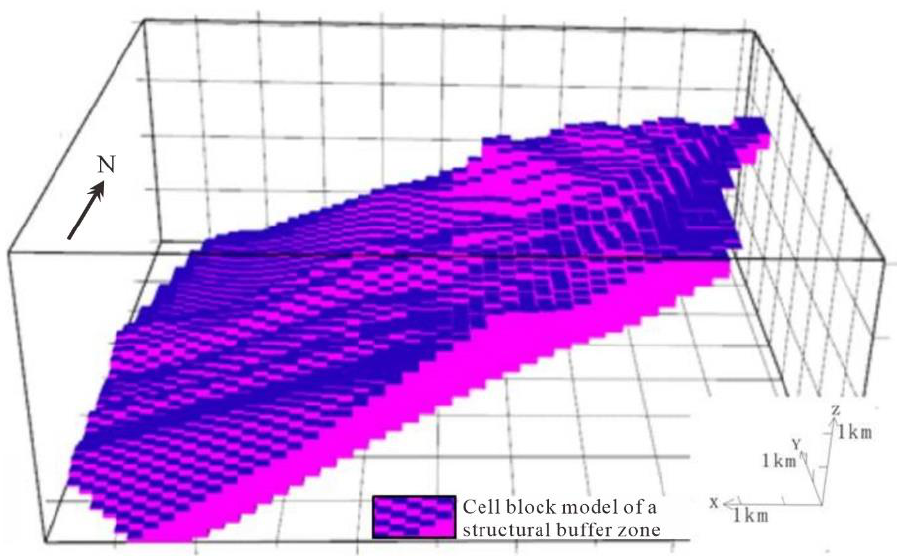
Figure 3. Distribution of cell blocks covered by structural buffer zones in the Jiaojia fault.